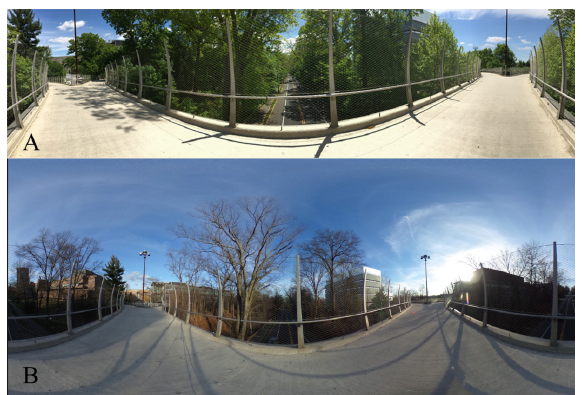
Figure 2. ( A ) Planar panorama ( B ) Spherical panorama (modified from